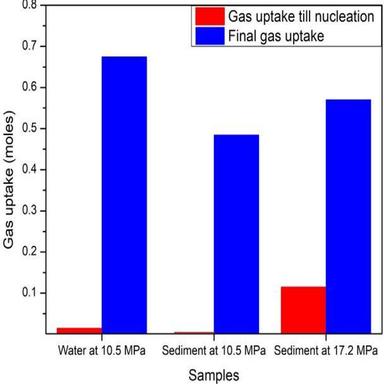
Induction time and Degree of sub-cooling observed in water and sediment sample. Fig. 14. Gas consumption in sediment samples at different conditions.